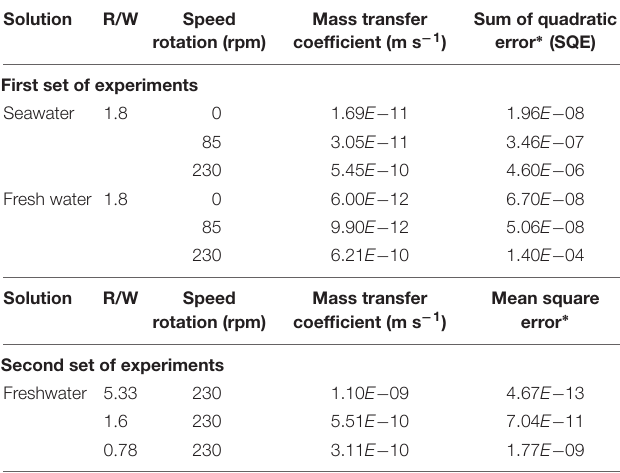
TABLE 5 | Mass transfer coefficient ( k ) for quartz grains in agitated solutions according to the various experimental conditions.